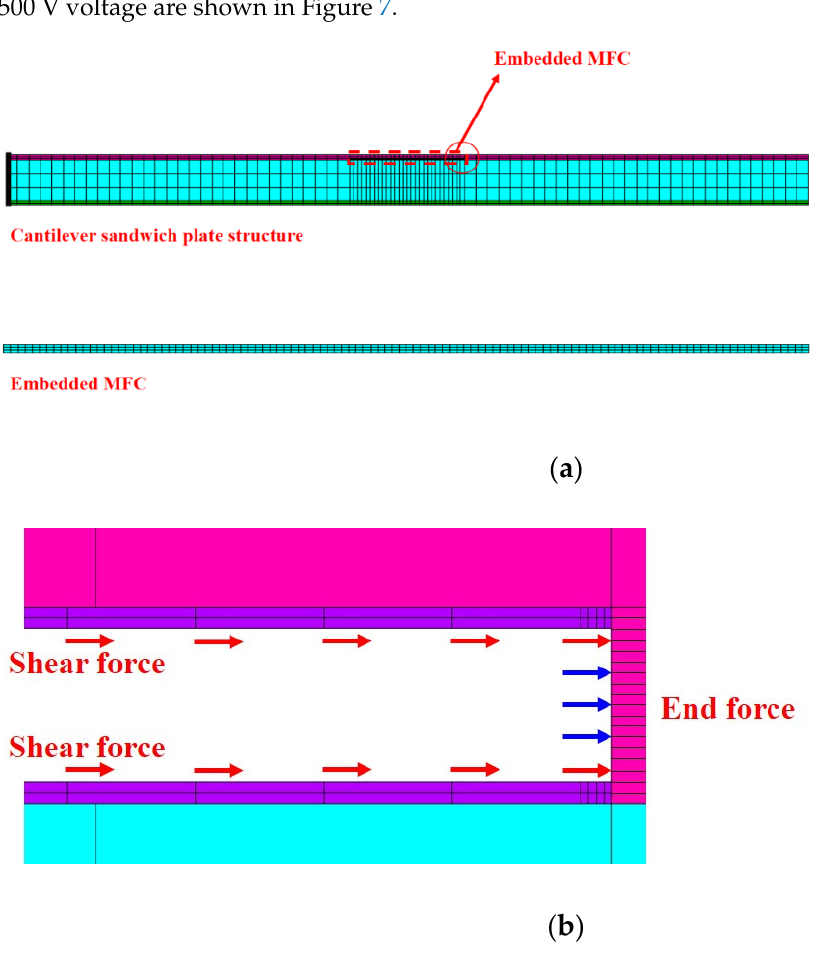
Figure 6. ANSYS finite element model of the sandwich plate structure with embedded MFC: ( a ) Finite element model; ( b ) action form of actuating stress.